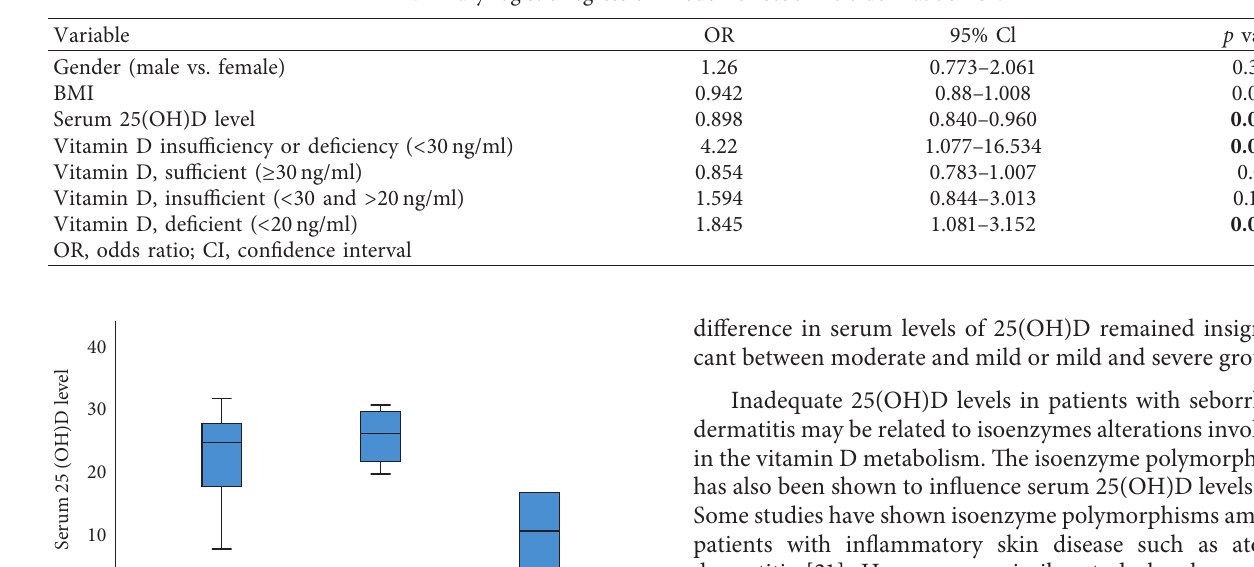
Table 1: Binary logistic regression model for seborrheic dermatitis risk.